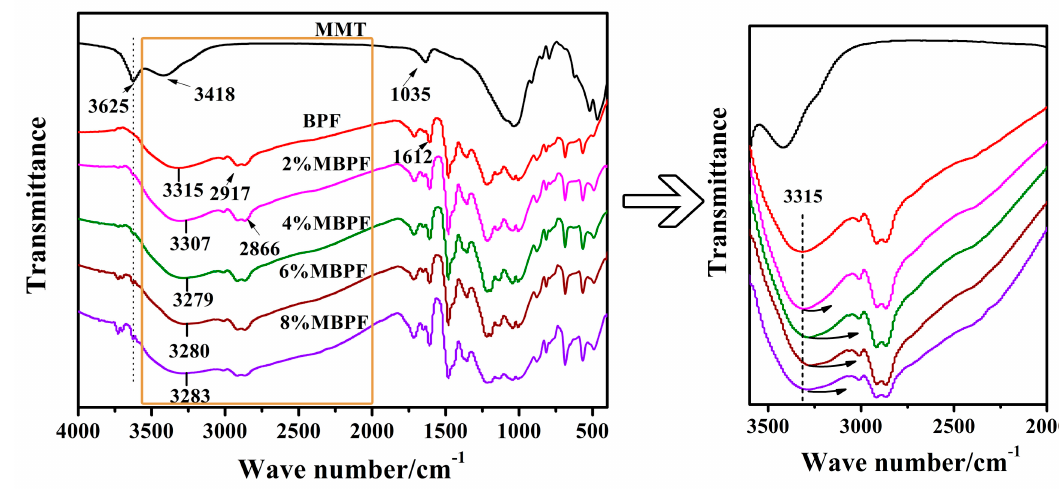
Figure 1. FT-IR of montmorillonite (MMT), BPF and MBPFs. Table 2. Peaks and assignment of FT-IR spectra for MMT, BPF and MBPFs.